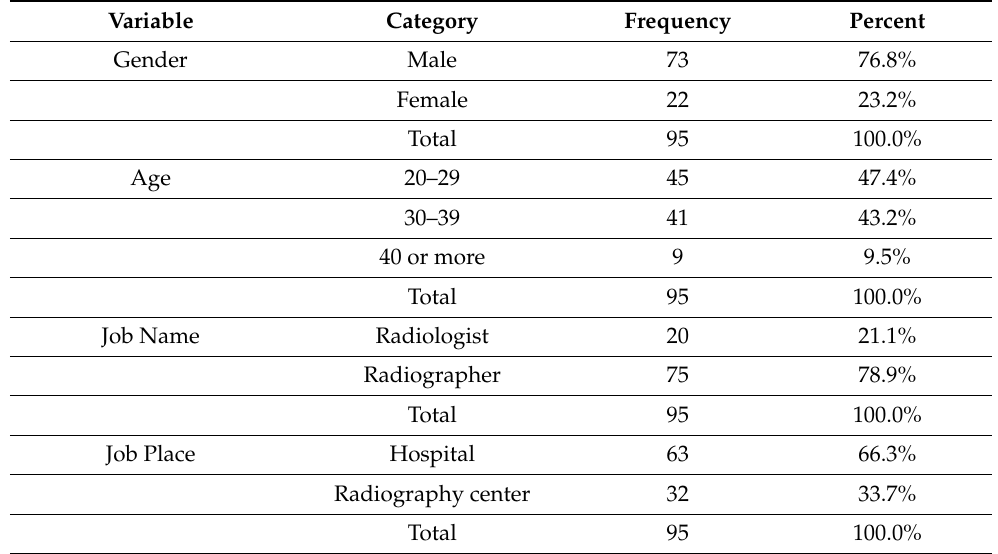
Table 1. Frequencies and percentages of the personal and demographic variables of the study